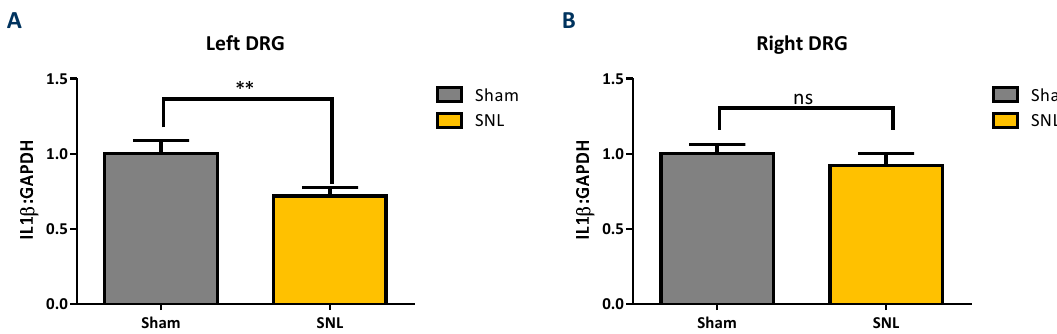
Figure 6. Comparison of cleaved IL-1 β protein level in ipsilateral and contralateral DRG for sham and vehicle groups. Cleaved, active IL-1 β protein levels in left (ipsilateral) DRG ( A ) significantly decreased in the vehicle group ( n = 10) compared to the sham ( n = 10). ( B ) No difference between the sham ( n = 10) and vehicle group ( n = 10) in right (contralateral) DRG. Data presented as the average ± SEM. An unpaired t-test was performed: ns, not significant; **, p < 0.01.